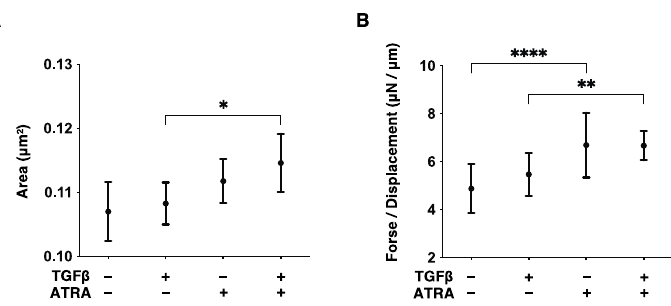
Figure 3. Effects of ATRA on the sizes and hardness of the TGF- β 2 untreated or treated HconF 3D spheroids. Three-dimensional HconF spheroids untreated and treated with TGF- β 2 (TGF β , 5 ng/mL) were analyzed for their size and hardness measurements in the presence or absence of 1 µ M ATRA. Mean sizes ( µ m 2 ) and the force required to compress to the semidiameter ( µ N/ µ m) of a single 3D spheroid within 20 s were plotted in panels ( A , B ), respectively. Experiments were repeated in triplicate using fresh preparations ( n = 16 spheroids each). Data are expressed as the mean ± standard error of the mean (SEM). * p < 0.05, ** p < 0.01 and **** p < 0.001; ANOVA followed by a Tukey’s multiple comparison test.